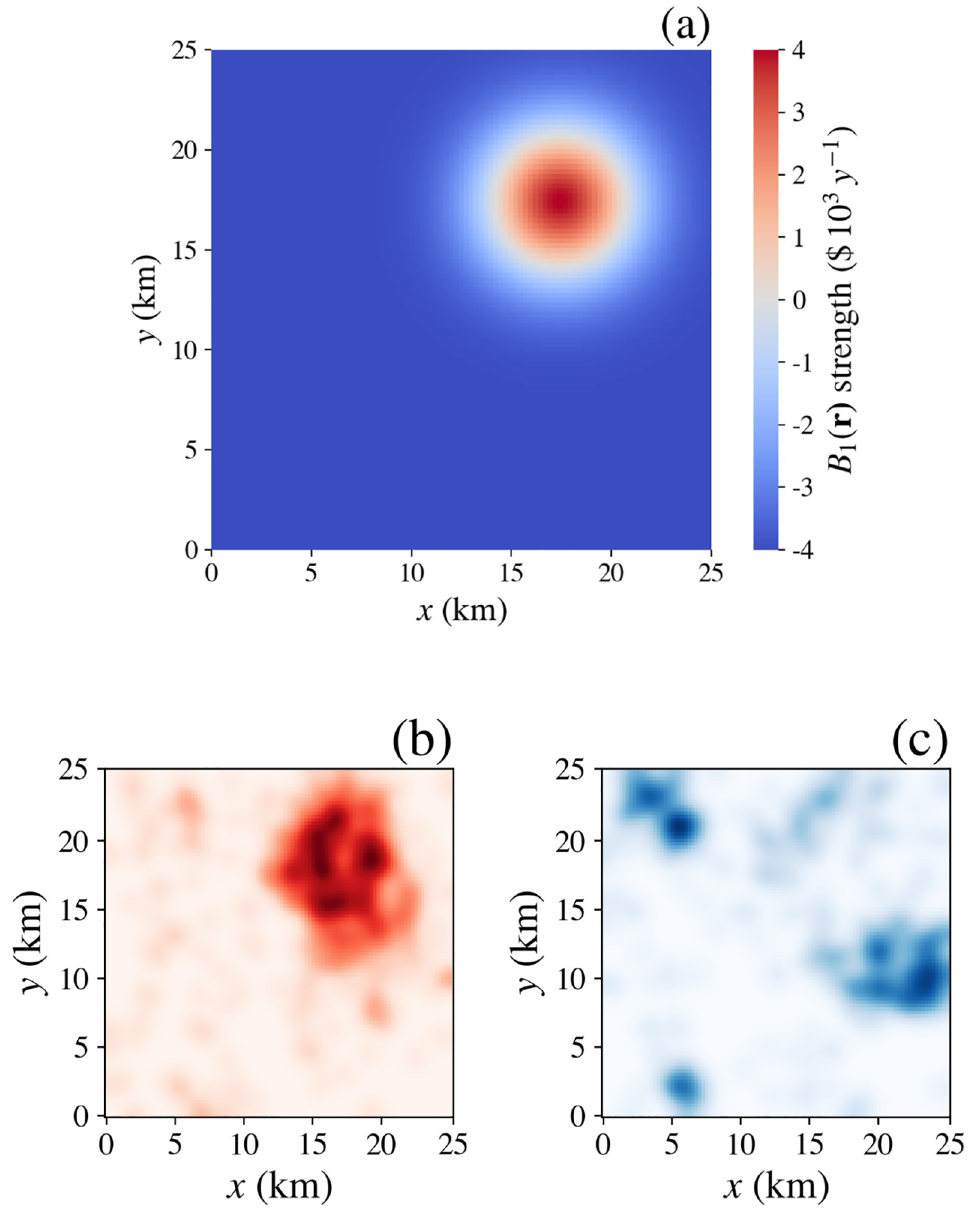
Fig 11. Effects of a spatially localized dwelling characteristic B 1 and after 25 years. (a) B 1 ( r ) vs. r with a spatial maximum at (17.5, 17.5) km. ( b ) Distribution of households with s 1 < 0 that seek positive B 1 . ( c ) Distribution of households with s 1 > 0 that avoid positive B 1